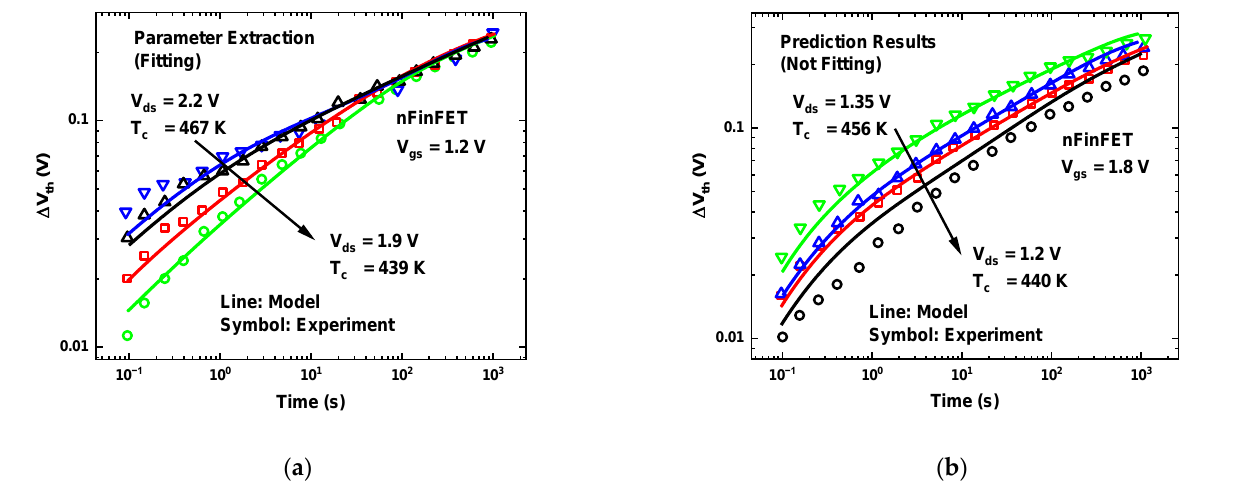
Figure 8. ( a ) nFinFET experiment data (from V ds = 2.2 V to 1.9 V) used for parameter extraction in SCE region ( V d dependence); ( b ) comparison between model predictions by using parameters extracted from data in SCE region (line) and experiment data (from V ds = 1.35 V to 1.2 V) in MCE region (symbol) of nFinFET. The experiment data well agree with the prediction results [29].